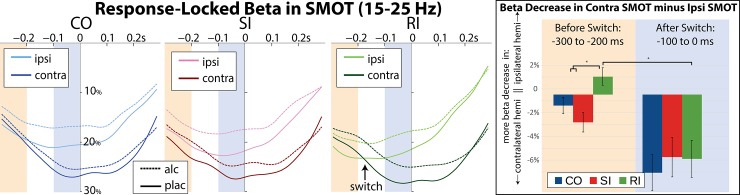
Beta power timecourses time-locked to the response (button press at time zero), expressed as percent change from baseline in the SMOT areas.Darker colors in each condition signify the contralateral hemisphere to the responding hand, which always has more beta decrease than the ipsilateral hand (lighter color) at the time of the response. On RI trials, the early time window of -300 to -200ms pre-response (highlighted in peach color) shows that the ipsilateral (primed) hemisphere has more beta decrease, but the two hemispheres switch at 173 ms before the response, marked by the arrow. After the switch and immediately preceding the response (highlighted in dark blue color), the primed hemisphere rebounds back to baseline while the responding hemisphere continues to decrease. In the right panel, lateralized beta power is presented in the bar graphs as a subtraction of beta power in the contralateral—ipsilateral SMOT in the early (-300 to -200 ms) vs late (-100 to 0 ms) time windows.